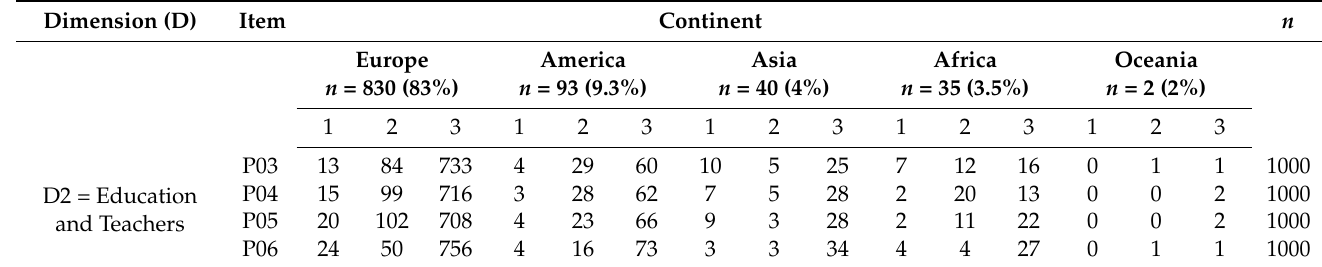
Table 11. Count by Continent of the participating sample for dimension D2.